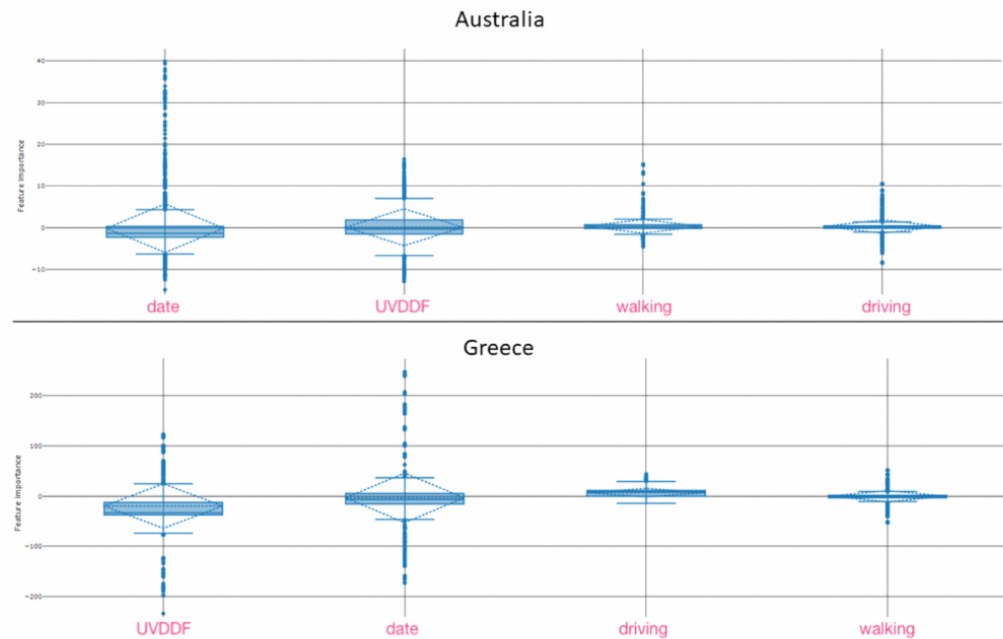
Figure 6. Examples of critical feature extraction for the model parameters in two target countries. Global feature importance was detected by meta-explainers (see Methods) that ranked the selected four model parameters against the conditional parameter, Covid-19 daily case rate. For Australia, date was followed by UVDDF and then mobility parameters; for Greece, UVDDF was followed by date and then mobility parameters. For details, see Methods. Full data for all target countries are available as Supplementary